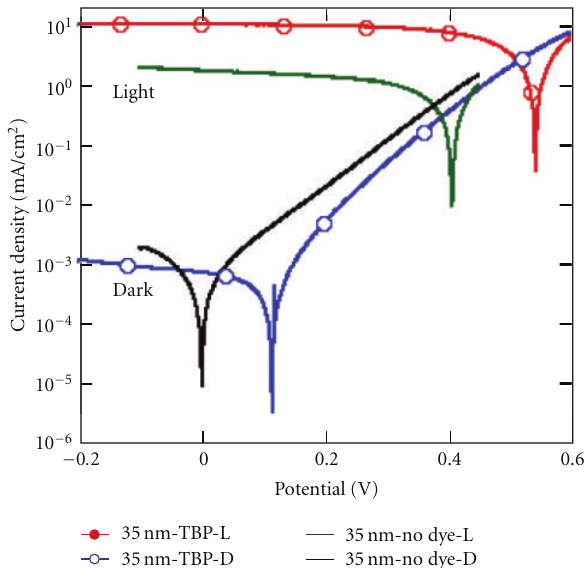
Figure 13: IPCE spectra of four hybrid solar cell device structures, namely, FTO/TiO 2 nanotube array/SK-1, SK-2, SQ-1, or no dye layer/P3HT/PEDOT:PSS/Au. The dye sensitization and PEDOT:PSS layer are identical in the four samples. Reprinted with permission from